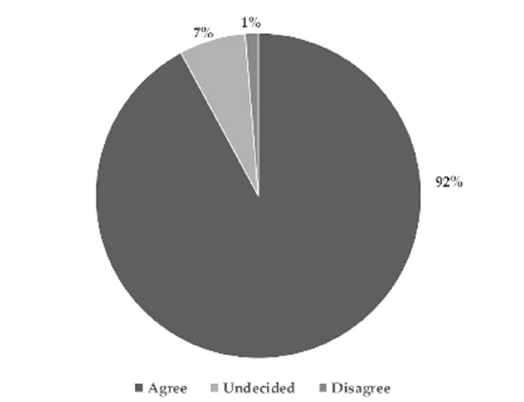
Figure 9. Students’ opinions on the adequacy of the videos for their learning.